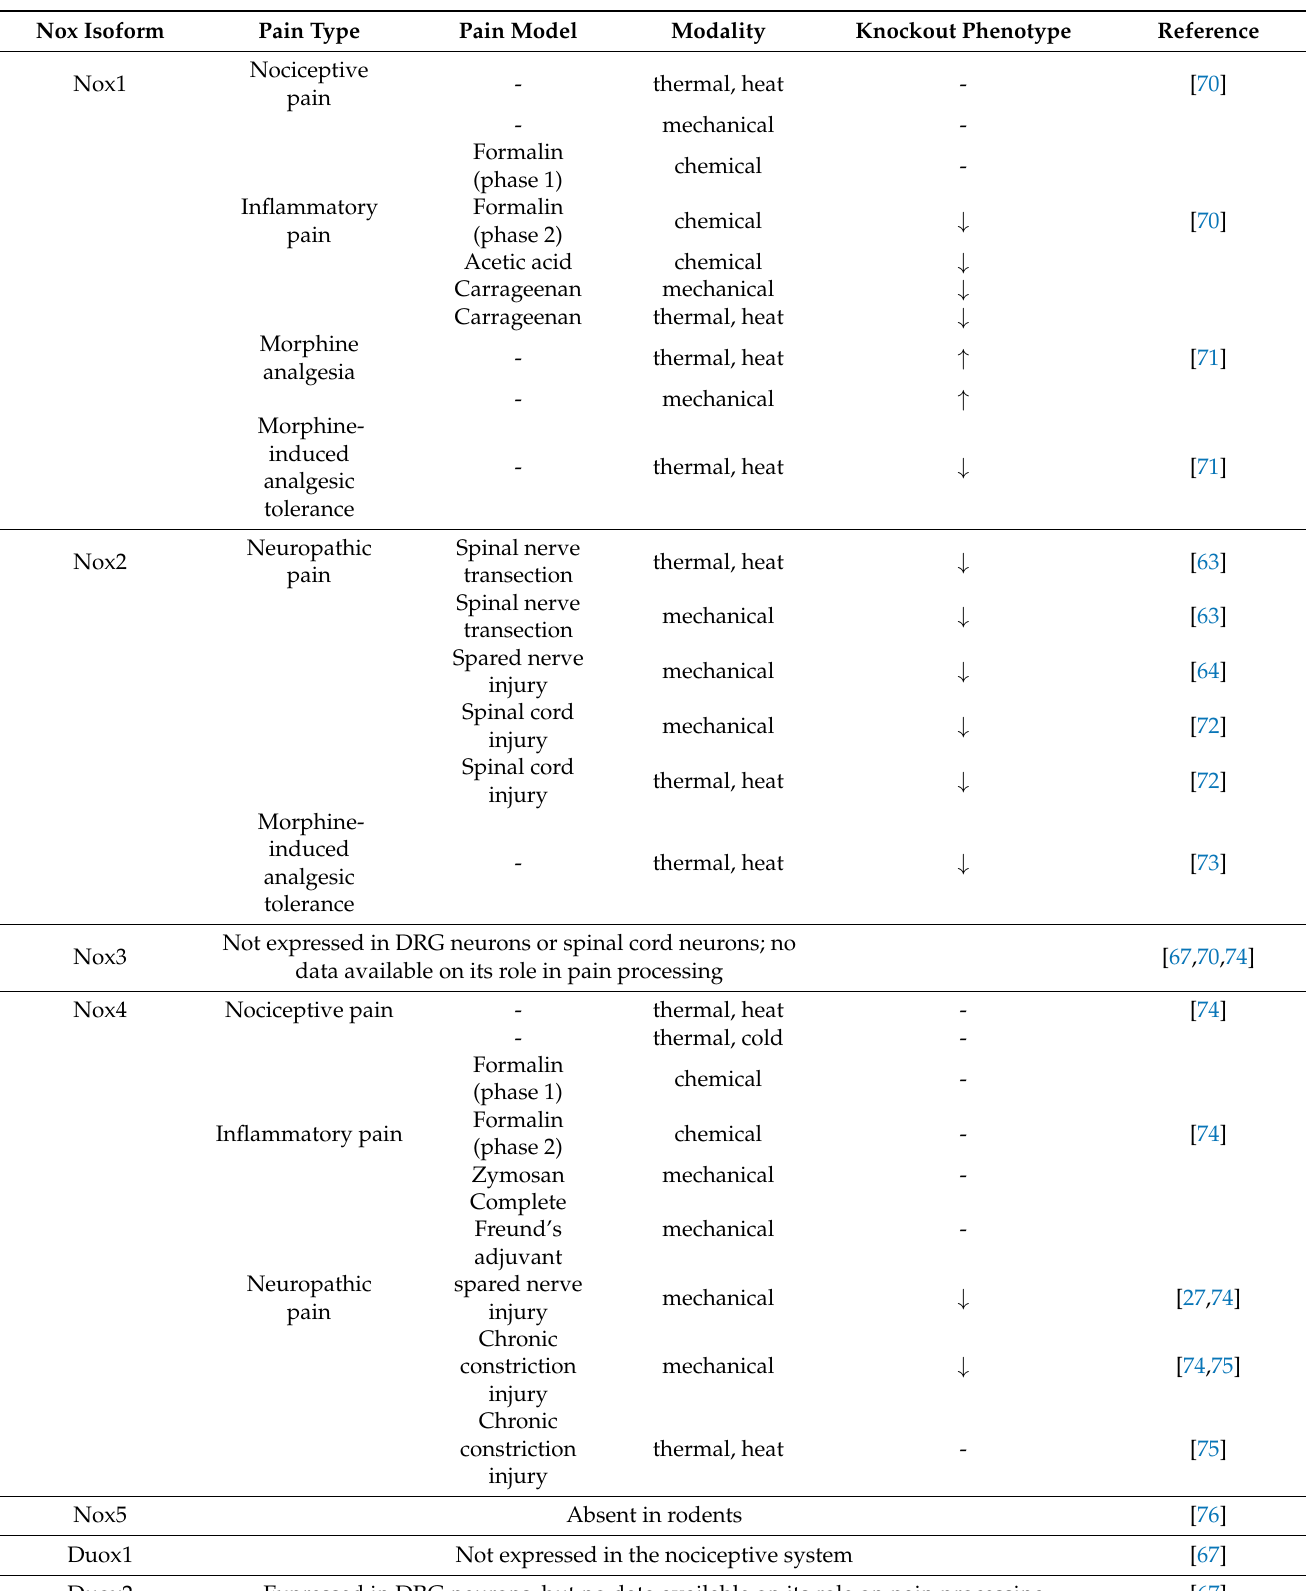
Table 1. Nox isoforms involved in pain